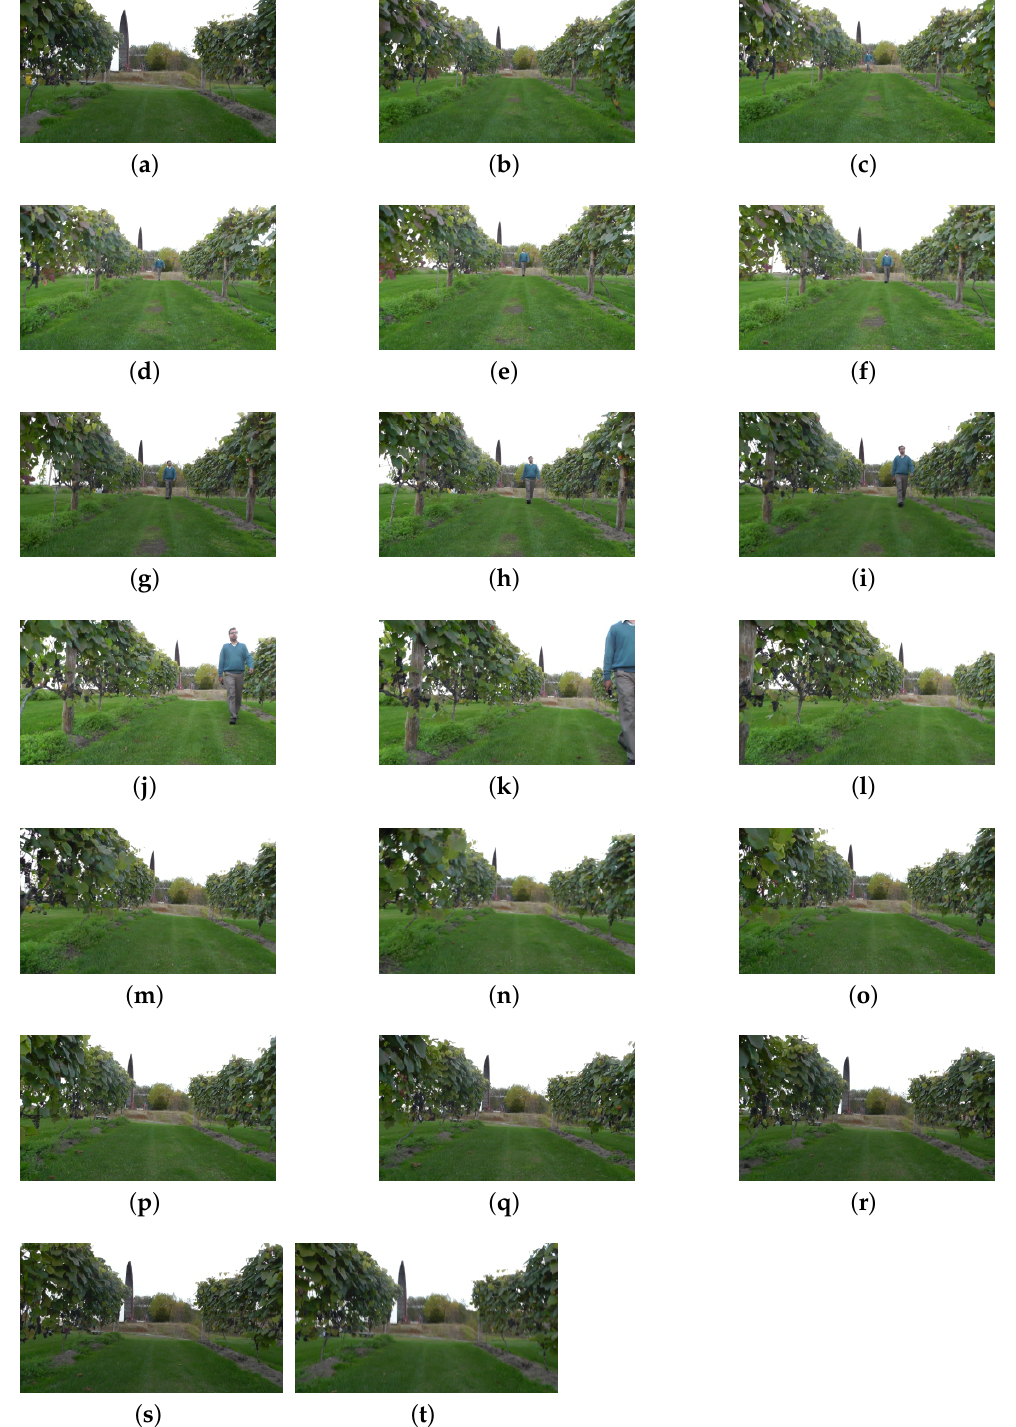
Figure 12. ( a – t ) Timely snapshots of dynamic obstacle (incoming person) avoidance in the vineyard using the proposed algorithm. The video of the experiment is provided in the supplementary